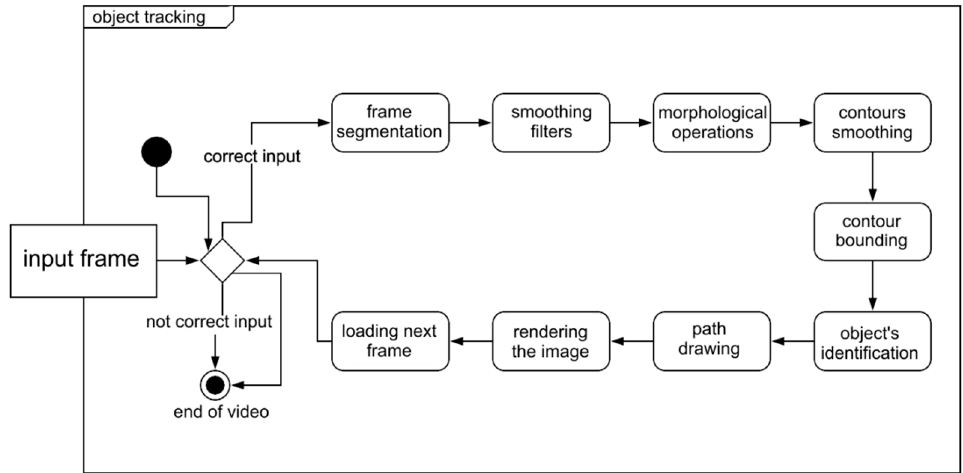
Figure 4. The basic scheme of the proposed detection procedure.